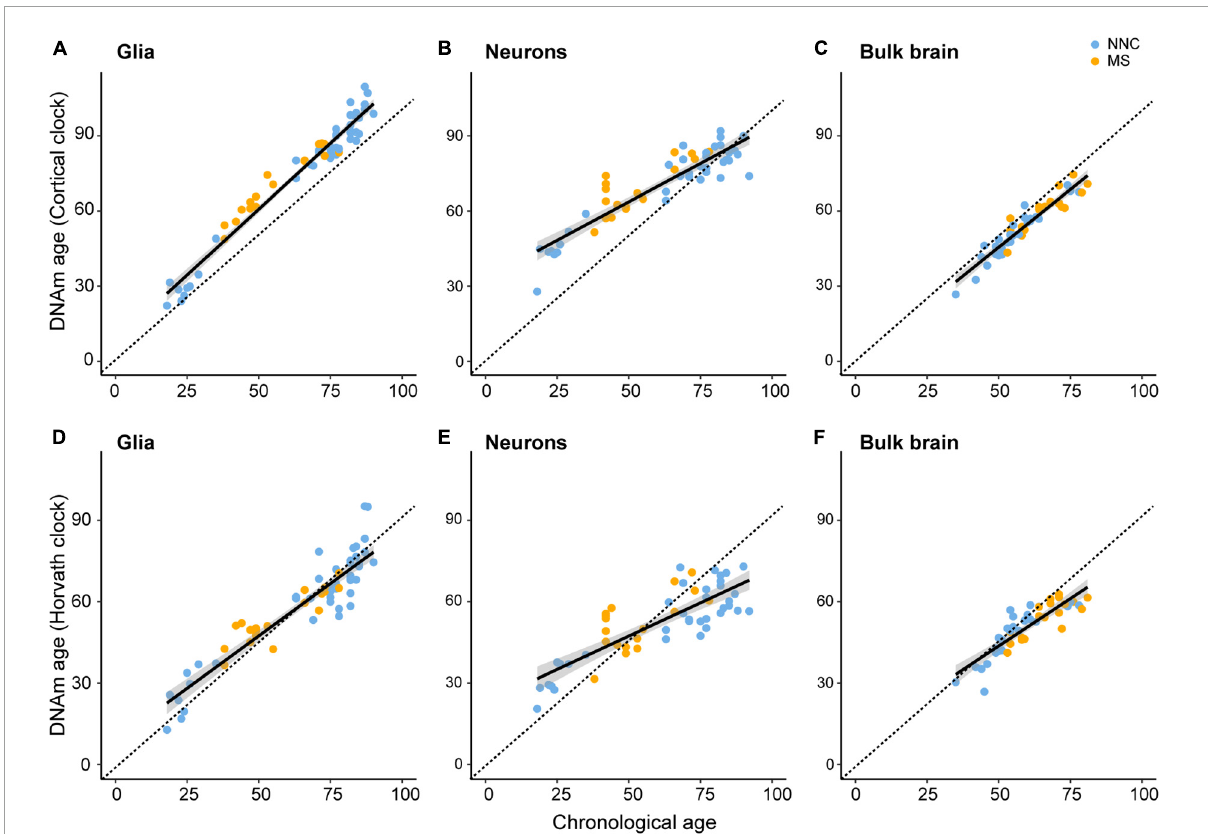
FIGURE1 Linear models of Cortical and Horvath’s clocks applied to glial cells, neurons, and bulk brain tissue. Linear models of regressing estimated DNAm age on chronological age with the DNAm age estimated with the Cortical clock [upper panels (A–C) ] or Horvath’s clock [lower panels (D–F) ]. Regression of DNAm age on chronological age was performed in glial nuclei (A,D) , neuronal nuclei (B,E), and bulk brain tissue (C,F) of multiple sclerosis (MS) patients and non-neurological controls (NNC). The dashed line represents the x = y bisector and the black line represents the linear regression line of best fit. For information on model characteristics, see Table 2 . Data were retrieved from Huynh et al. (2014), Kozlenkov et al. (2014), Gasparoni et al. (2018), and Kular et al. (2019, 2022).